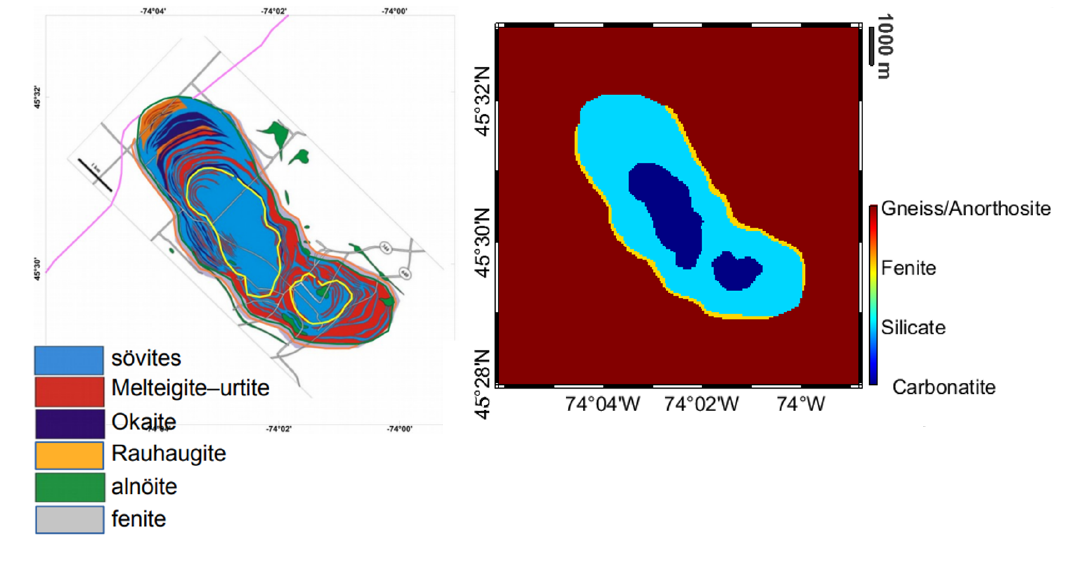
Figure 2. Detailed geological model of Oka Carbonatite complex from [29,33] ( left ) and simplified geological model used to build the a-priori model ( right ).